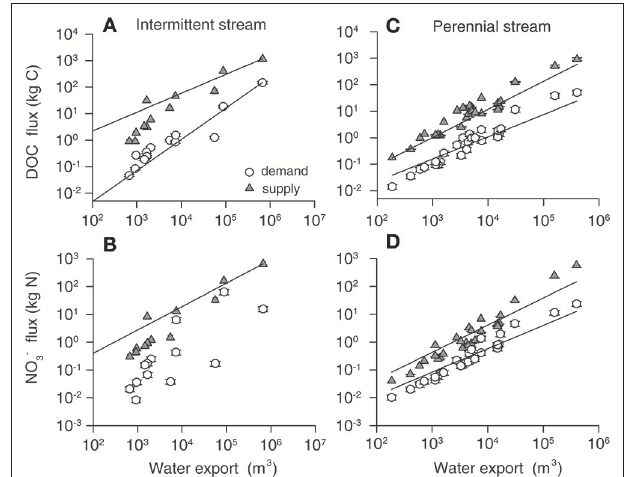
FIGURE 4 | Relationship between water export and supply from upstream and riparian groundwater sources ( E up + E gw ) (triangles) and whole-reach demand (circles) estimated from in-stream areal uptake rates ( U ) of dissolved organic carbon (DOC) and nitrate (NO − 3 ) for individual storm events at the intermittent stream Fuirosos (A,B) and the perennial stream Font del Regàs (C,D) . Error bars indicate the uncertainty associated with supply and demand fluxes (see text for details). Note that error bars are small and even not distinguishable in some cases. The solid lines indicate regression models only when statistically